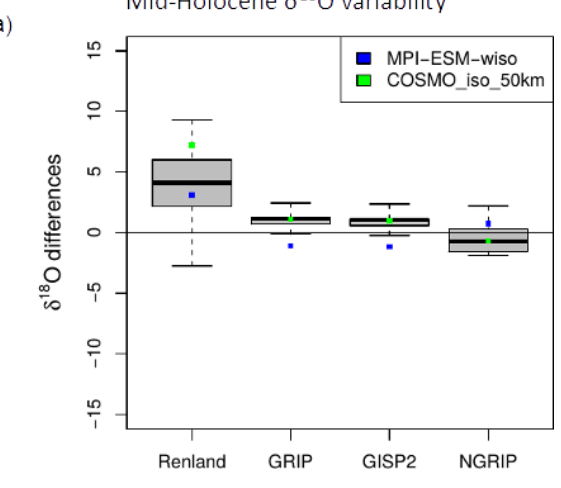
model results are in agreement with the isotopic ratios of the ice core